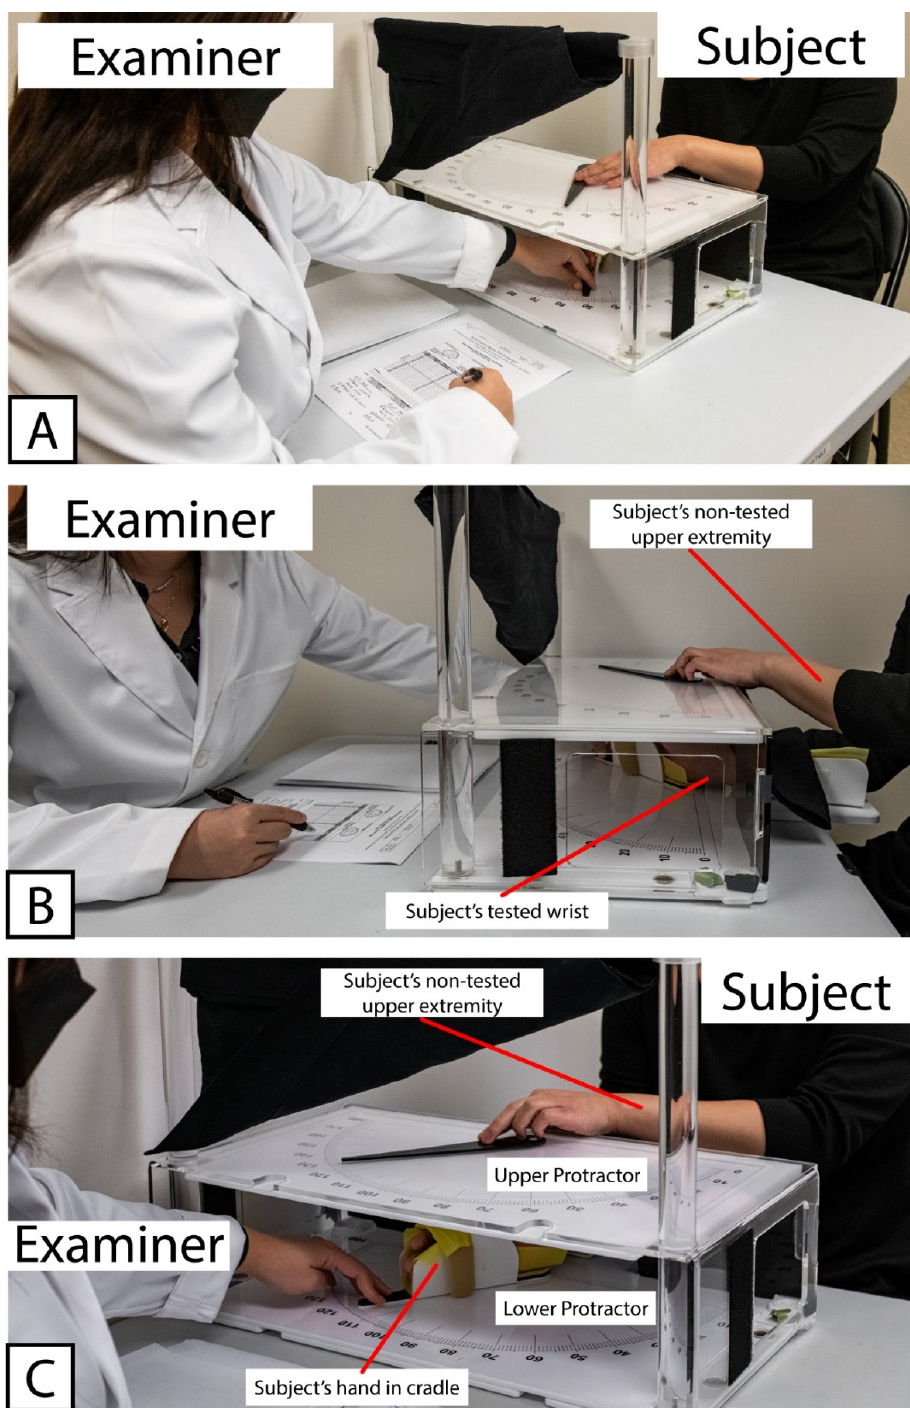
Figure 1. Example showing positioning of Examiner, Subject, and testing apparatus used for Wrist Position Sense Test administration. ( A ) Relative positioning of Examiner and Subject, with WPST Apparatus situated between them. ( B ) Positioning of Subject’s tested wrist within WPST apparatus, as well as non-tested upper extremity used to manipulate pointer on the top surface of WPST apparatus. ( C ) Relative placement of Upper and Lower Protractors. Note that the Upper Protractor obstructs the subject’s line of sight, preventing subject’s ability to view the tested wrist.